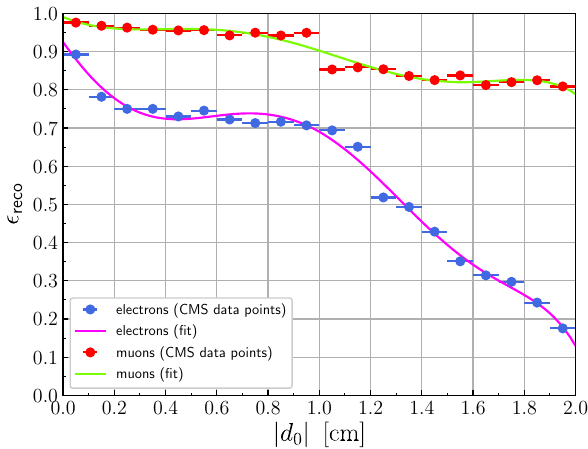
Fig. 2 Electronandmuonreconstructionefficienciesasextractedfrom the superseded CMS analysis [63]. The plot was generated with data files from the corresponding HEPData entry [65] and the polynomial fits of Eq. (3.2) generated by the author of